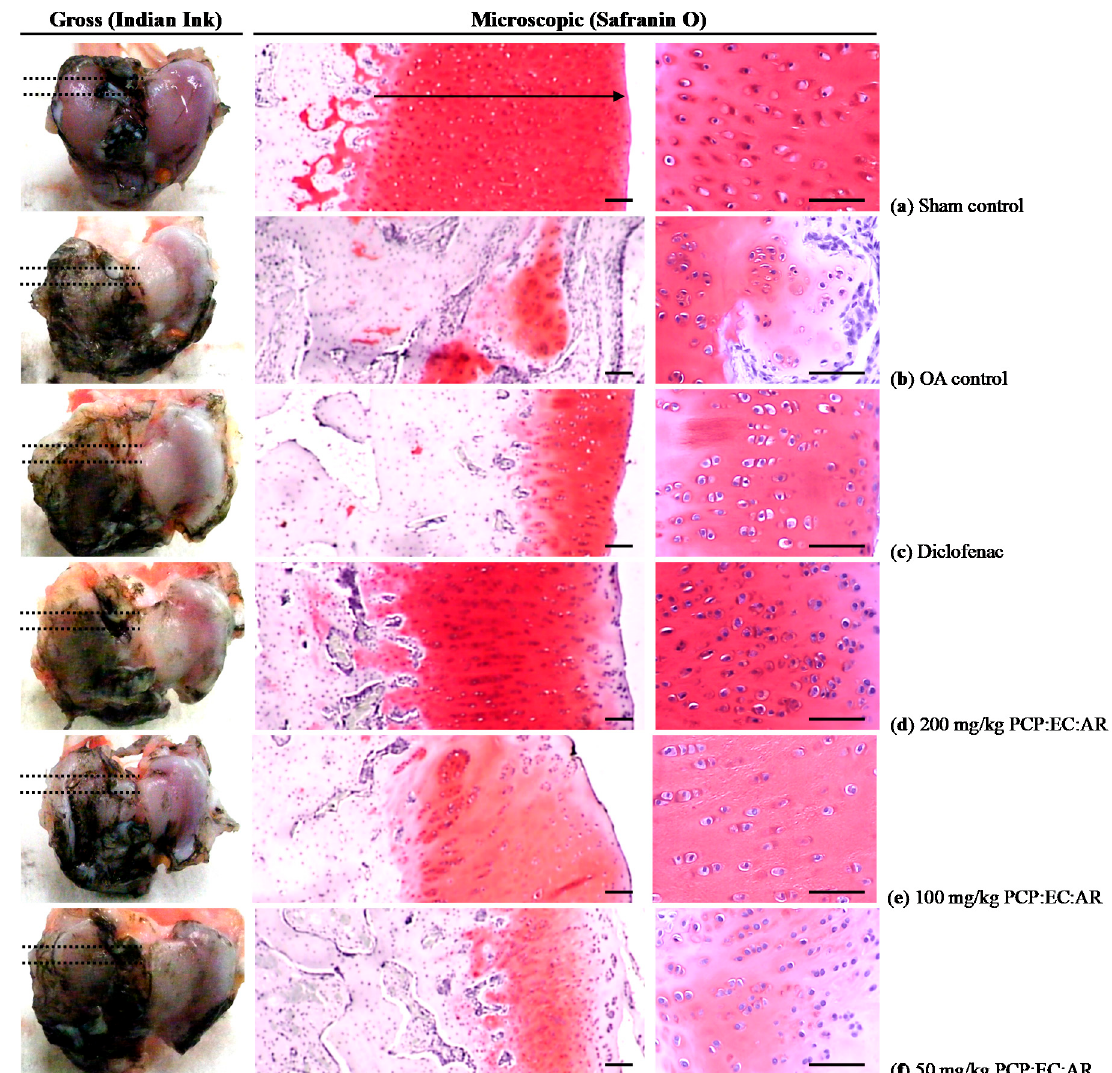
Figure 5. Representative gross and general histological images of the tibia articular surface cartilages, taken from sham-operated or OA rabbits. ( a ) Sham vehicle control (sham-operated and distilled water orally administered rabbits); ( b ) OA control (OA-surgery and distilled water orally administered rabbits); ( c ) Diclofenac (OA-surgery and diclofenac sodium 2 mg / kg subcutaneously treated rabbits); ( d ) PCP:EC:AR mixed formula 200 mg / kg orally administrated OA rabbits; ( e ) PCP:EC:AR mixed formula 100 mg / kg orally administrated OA rabbits; ( f ) PCP:EC:AR mixed formula 50 mg / kg